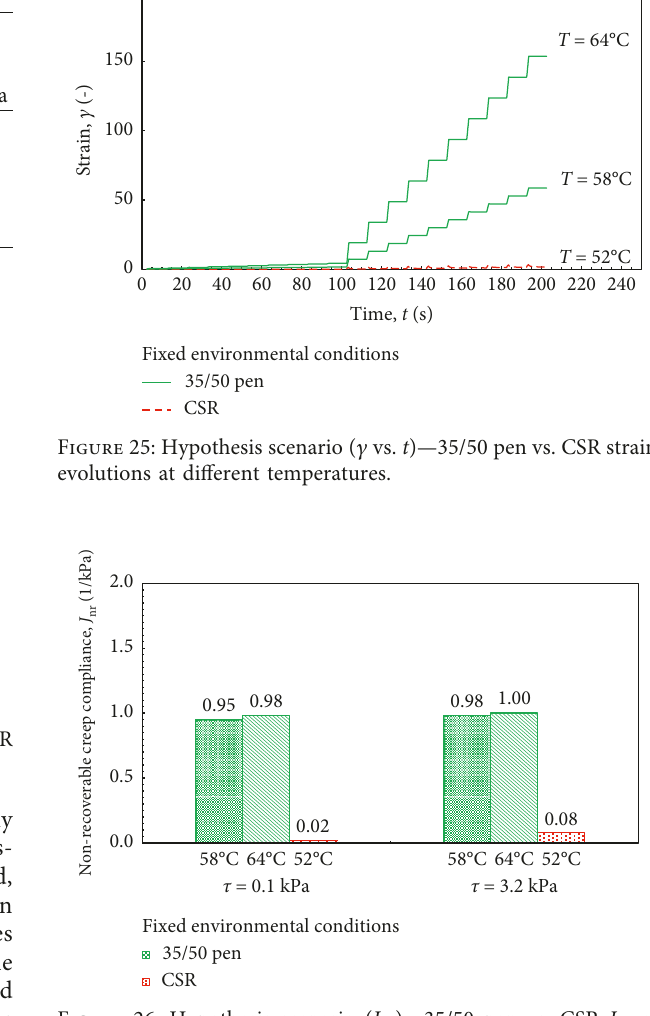
nr )—35/50 pen vs. CSR J nr at